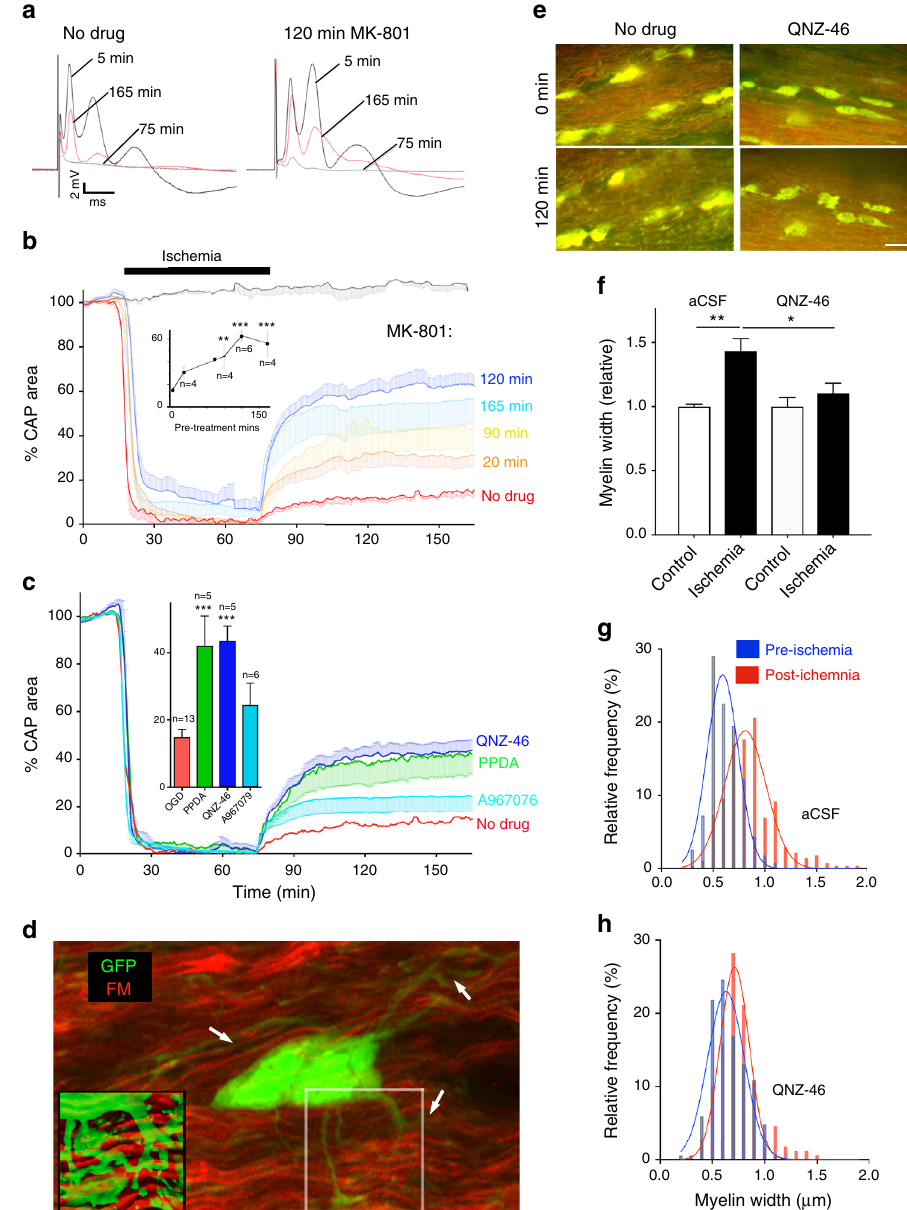
Fig. 4 Myelin injury is NMDA-receptor-mediated. a CAP recordings from adult rat RON showing elevated functional recovery from ischemia following 120 min MK-801 pre-treatment. b Ischemia-evoked loss and recovery of function following different periods of MK-801 pre-treatment (insert: data summary). ANOVA with Holm − Š ídák post test. P values: 90 min **0.002; 120 min ***0.0001; 165 min ***0.0000. c 120 min pre-treatment with selective NMDA receptor GluN2C/D blockers QNZ-46 ( P = 0.0013) or PPDA ( P = 0.0009), or the TRPA1 blocker A967076. d Oligodendrocyte cytoplasmic domain (PLP- GFP mouse, arrows) is distinct from the myelin domain (FM: fl uoromyelin red) in live adult mouse RON. Highlighted square shown in insert as rendered stack. e Myelin structure is protected from ischemic damage by 120 min pre-treatment with QNZ-46, imaged via FM vital staining. f – h Ischemia evoked myelin swelling ( P = 0.000 in aCSF) is prevented by 120 min QNZ-46 pre-treatment ( P = 0.047 vs. aCSF). Scale = 10 μ m